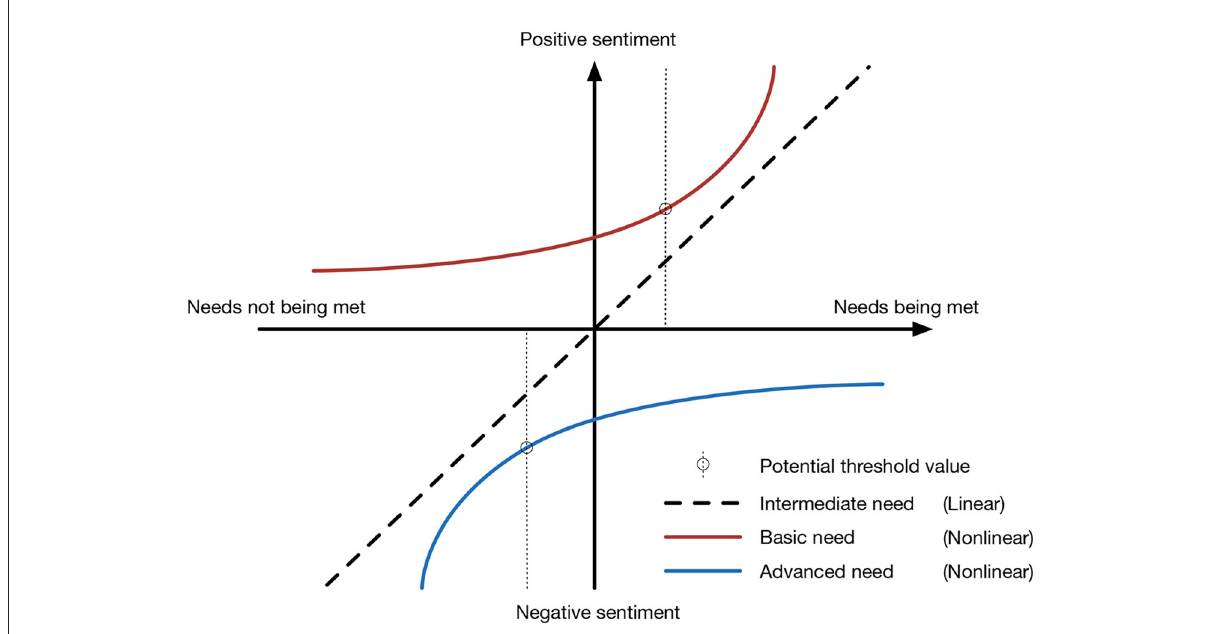
FIGURE3 Three correlations between residents’ needs and